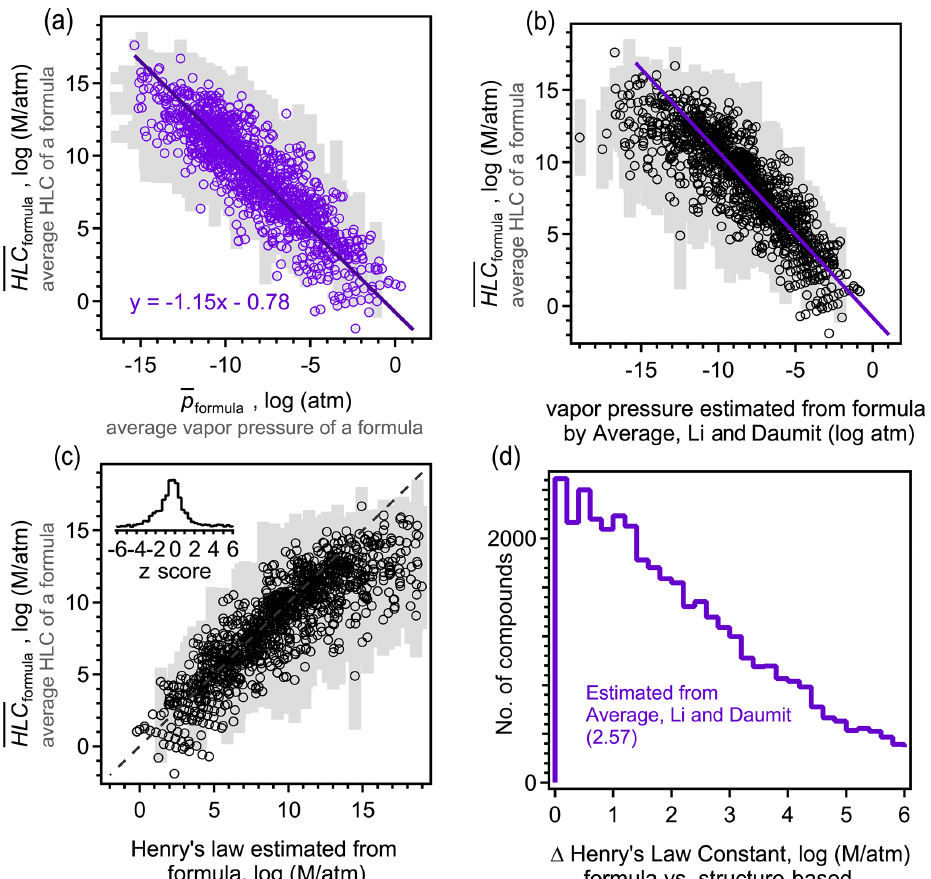
Figure 5. Comparison between HLC formula (average HLC of all methods and all isomers) and (a) p formula , the average vapor pressure of a formula with best fit line shown, and (b) the estimated vapor pressure using the formula-based average Daumit–Li method estimate, with same fit line shown in purple. (c) Comparison between HLC formula and the HLC estimated from vapor pressure calculated from the Daumit–Li method using the best-fit equation shown in (a) . Each formula is represented as an open circle at HLC formula , with light gray bars representing a standard deviation of the average, σ p , to indicate the approximate range. (d) Distribution of error from applying this method to any given compound, with all oxidation system combined and the average value provided in